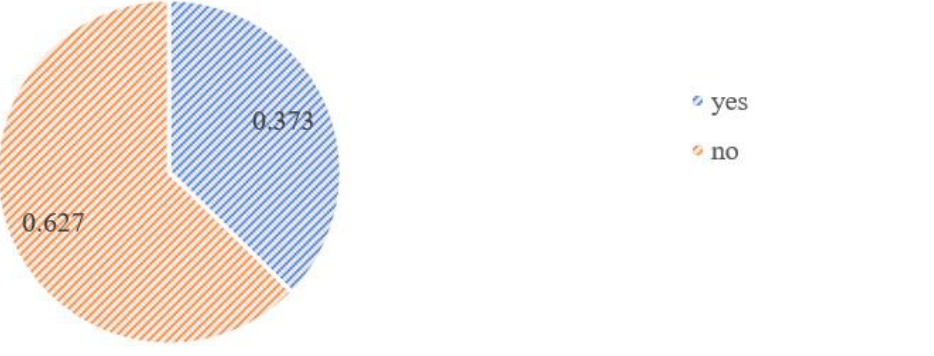
Figure 1. The frequency analysis graph for the answer to the question “ Does the SARS-CoV-2 pan- demic have/had an impact on the choice of delivery place? ” .